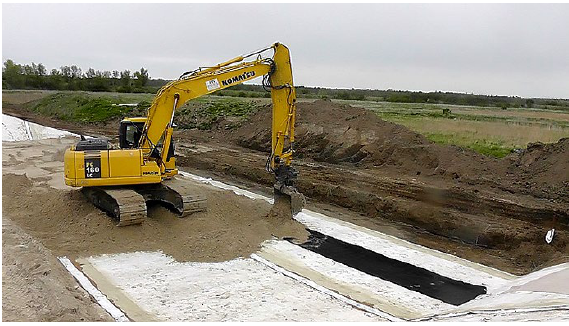
Fig. 12. Installation of the geosynthetic clay liner and drainage composite